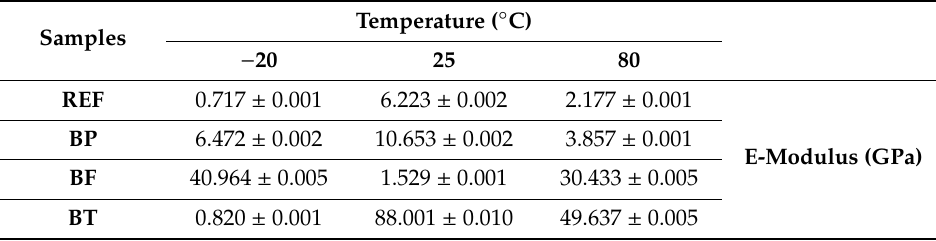
Table A2. Appendix A contains details and data supplemental to Figure